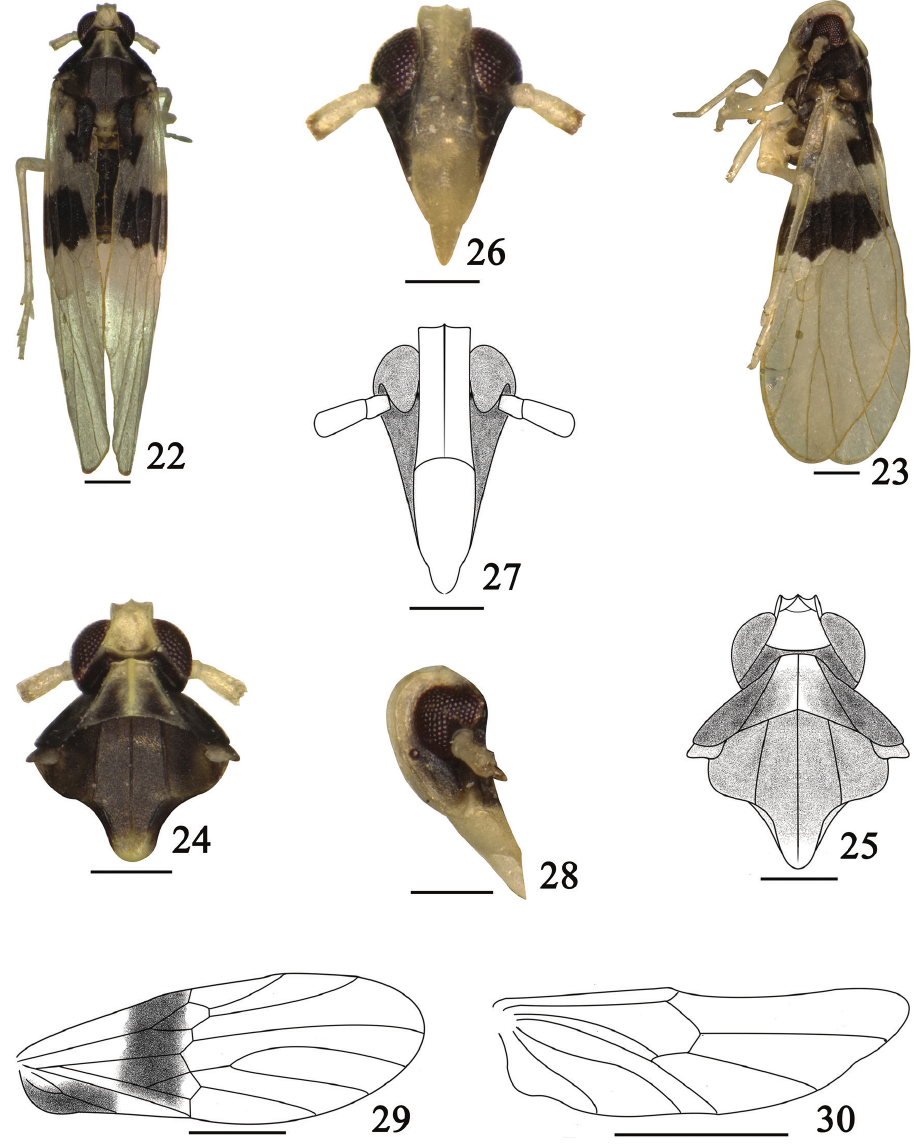
Figures 22–30. Bambusiphaga ventroprocessa sp. n. 22 Male habitus, dorsal view 23 Same, lateral view 24 – 25 Head and thorax, dorsal view 26 – 27 Frons and clypeus 28 Same, lateral view 29 Forewing 30 Hindwing. Scale bars 22 – 28 0.2 mm; 29 – 30 0.5 mm. Etymology. The specific name is a combination of the Latin word venter (trun- cated, with o- connecting vowel), meaning belly, ventral; and the Latin word processus , meant in the modern biological sense of a projection or appendage, truncated with the feminine termination - a